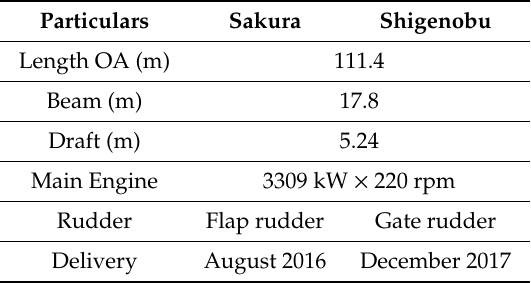
Figure 1. ( a ) Gate rudder system (GRS) on coastal container ship “Shigenobu.” and ( b ) conventional flap-rudder system (CRS) on sister container ship “Sakura.”. Table 1. Principal characteristics of Shigenobu and Sakura.